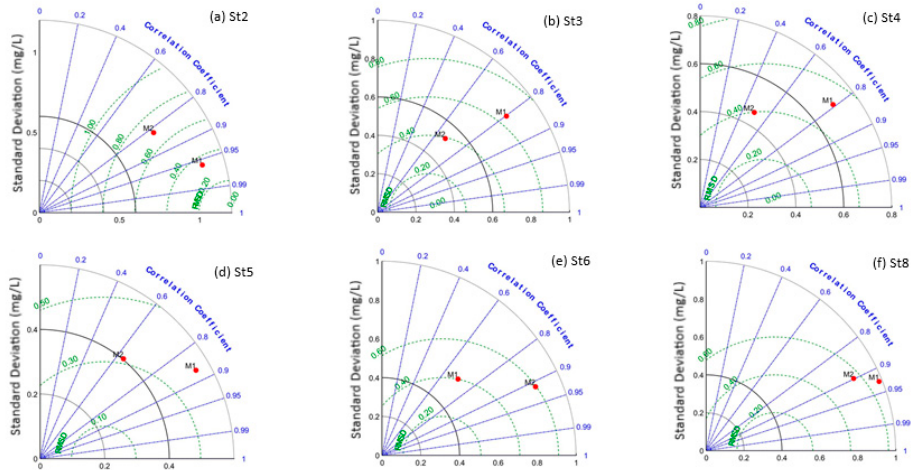
Figure 20. Taylor diagrams for SC1 (M1) and SC2 (M2), for inorganic nitrogen concentration, IN, and the stations: ( a ) St1, ( b ) St3, ( c ) St4, ( d ) St5, ( e ) St6 and ( f ) St8.